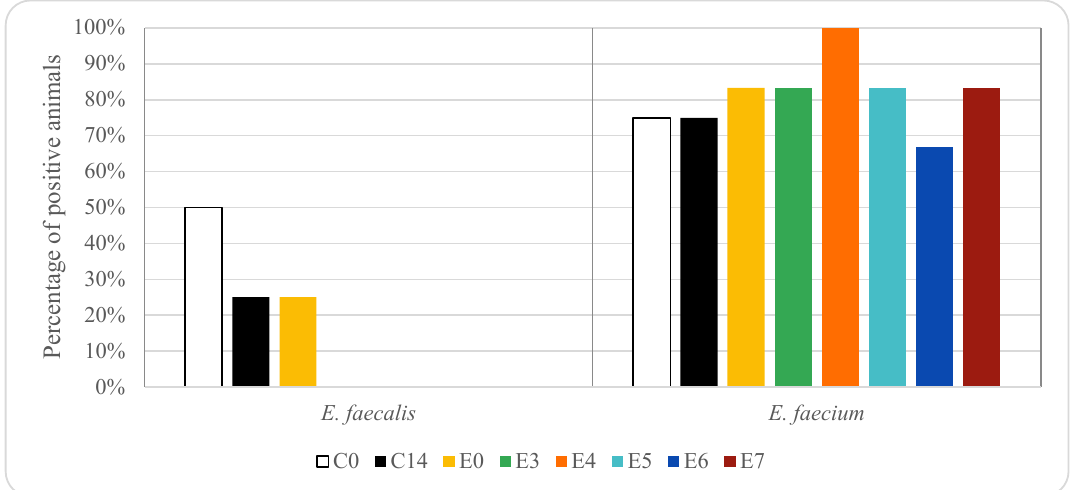
Figure 2. Effect of enrofloxacin treatment on vancomycin-resistant enterococci in pig rectal samples. For group descriptions C0, C14, E0, E3, E4, E5, E6, E7: see Table 1. Figures 3 and 4 show the percentage of animals in which VRE isolates were found in genital samples from pigs treated with oxytetracycline and enrofloxacin, respectively. In the genital samples, E. faecalis and E. faecium resistant to vancomycin were not detected in control animals. In the animals treated with oxytetracycline, E. faecalis and E. faecium resistant to vancomycin were only detected on day 6 after treatment (17% E. faecalis and 17% E. faecium , one piglet). In the animals treated with enrofloxacin, E. faecium resistant to vancomycin was detected in 17–50% of the animals (between one and three piglets), depending on the sampling day. No E. faecalis resistant to vancomycin was detected in genital samples from animals treated with enrofloxacin, except on day 3, when both E. faecalis and E. faecium were isolated from 17% of the animals (one piglet). Significant differences ( p < 0.05) in the prevalence of vancomycin resistant E. faecium were found in genital samples among the three groups of animals studied, and thus depended on antibiotic treatment. 0%10%20%30%40%50%60%70%80%90%100%